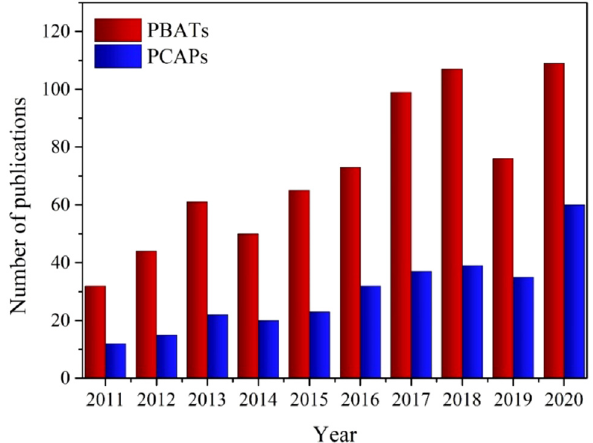
Figure 1: Annual publication number on integrated photobatteries (red) and photocapacitors (blue). Data were retrieved from Web of Science on November 09th, 2021, by searching “ TS = (solar rechargeable bat* or photo-assisted bat*) ” and “ TS = (photocapac* or photosupercapac* or photo integrated supercapac*) ”